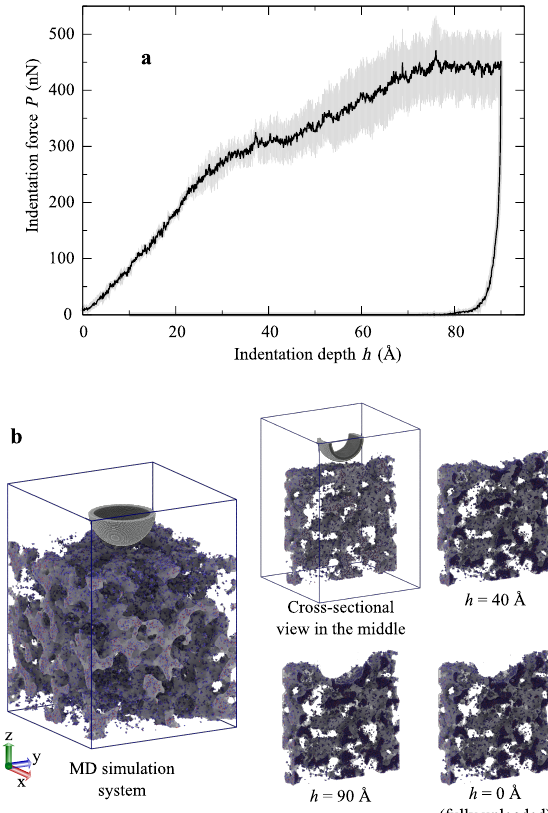
Figure 2. ( a ) Indentation force versus depth curve of the nanoindentation test on native silica aerogel. The black line is the average from indentation force–depth curves of different starting structure models, and the gray shaded area indicates the standard error deviation. ( b ) Snapshots of the native silica aerogel during the nanoindentation test. For understanding purposes, the deformation images of loading and unloading were taken at the middle cross-sectional view with a thickness of